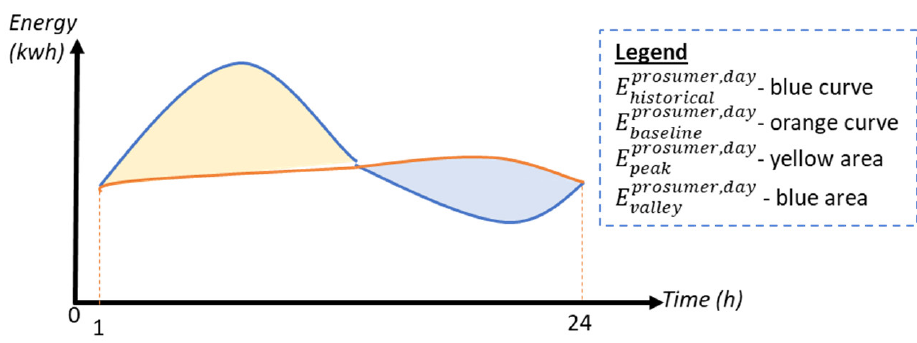
Figure 2. Decomposition of prosumer energy data in baseline, peak, and valley profiles.